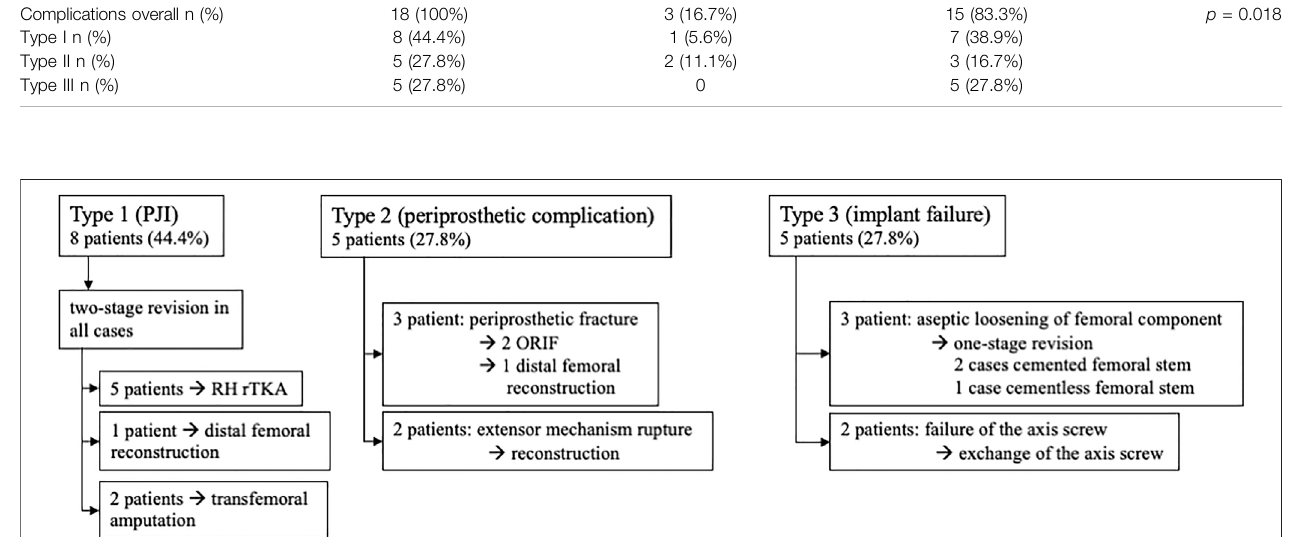
FIGURE 5 | Complications leading to revision surgery after RH TKA occurred in 18 patients. The fl ow chart shows a comprehensive overview on the types of complication and the following procedure. Percentages in brackets relate to the number of all complications.